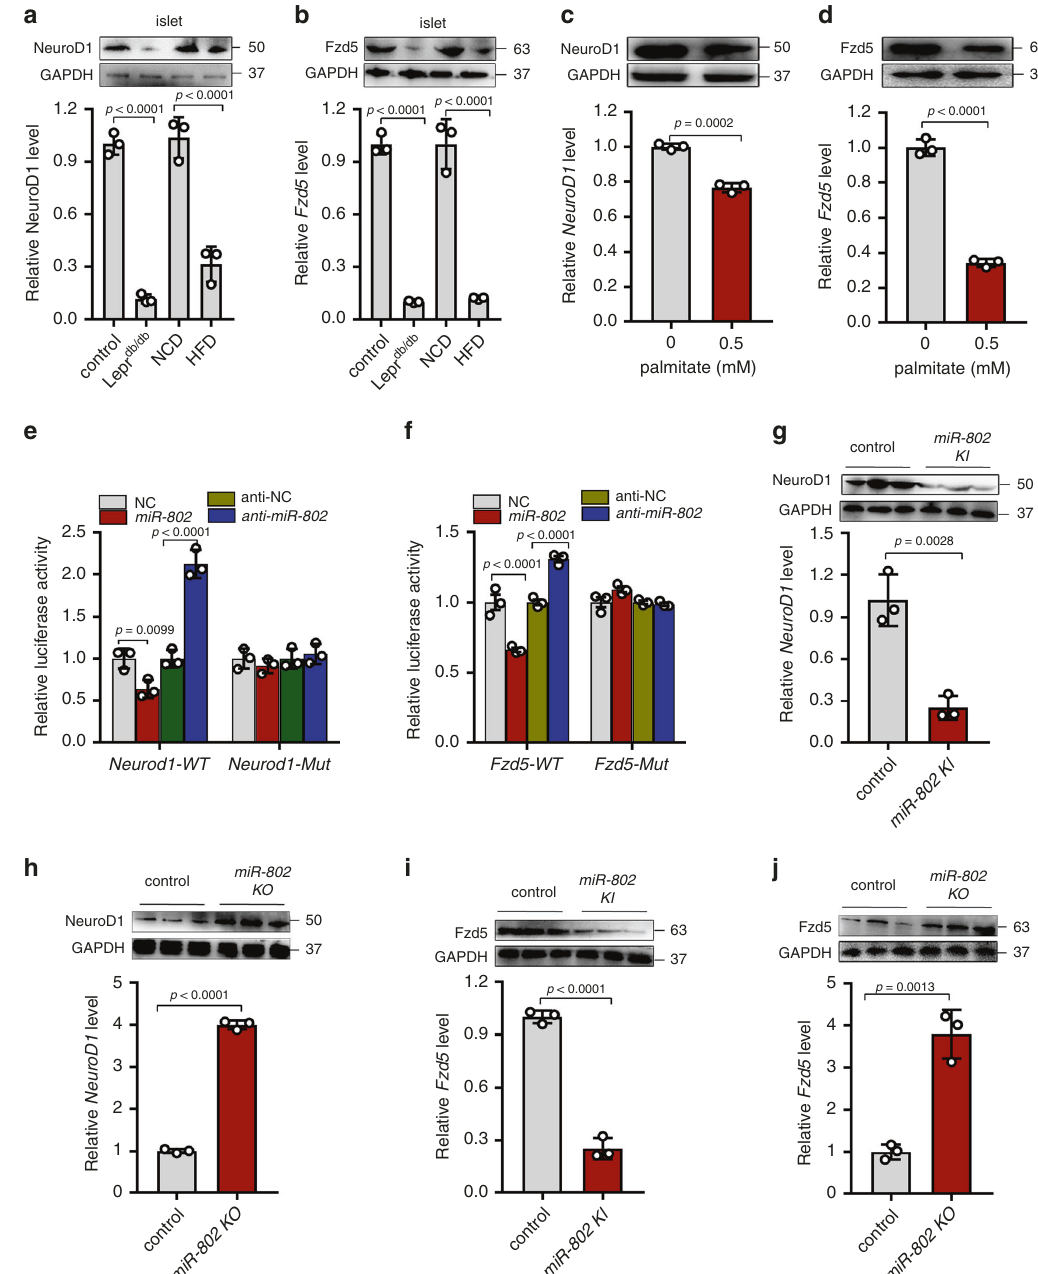
Fig. 6 Validation of target genes of miR-802 . qRT-PCR and western blot were performed to determine the expression of NeuroD1 ( a ) and Fzd5 ( b ) in the islets of HFD mice compared to NCD mice and in the islets of Lepr db/db mice at 8-week-old compared to wide type control mice ( n = 5). Islets were incubated with 0.5 mM palmitate for 48 h, and qRT-PCR and western blot were performed to investigate the expression levels of NeuroD1 ( c ) and Fzd5 ( d ). Relative luciferase activity of the fi re fl y reporter constructs containing either the wild type or mutated 3 ’ UTR of the murine NeuroD1 ( e ) and Fzd5 ( f ) gene. Fire fl y luciferase activity was normalized to the activity of Renilla luciferase. The mRNA and protein levels of NeuroD1 ( g , h ) and Fzd5 ( i , j ) in the islets of miR-802 KI and miR-802 KO mice compared to control ( n = 6, 8 – 10 weeks old). All experiments above were performed in triplicates, and each group contained three batches of individual samples. The p -values by two-tailed unpaired Student ’ s t test ( c , d , g – j ), one-way ANOVA ( a , b ), or two-way ANOVA ( e , f ) are indicated. Data represent the mean ± SD. Source data are provided as a Source Data fi